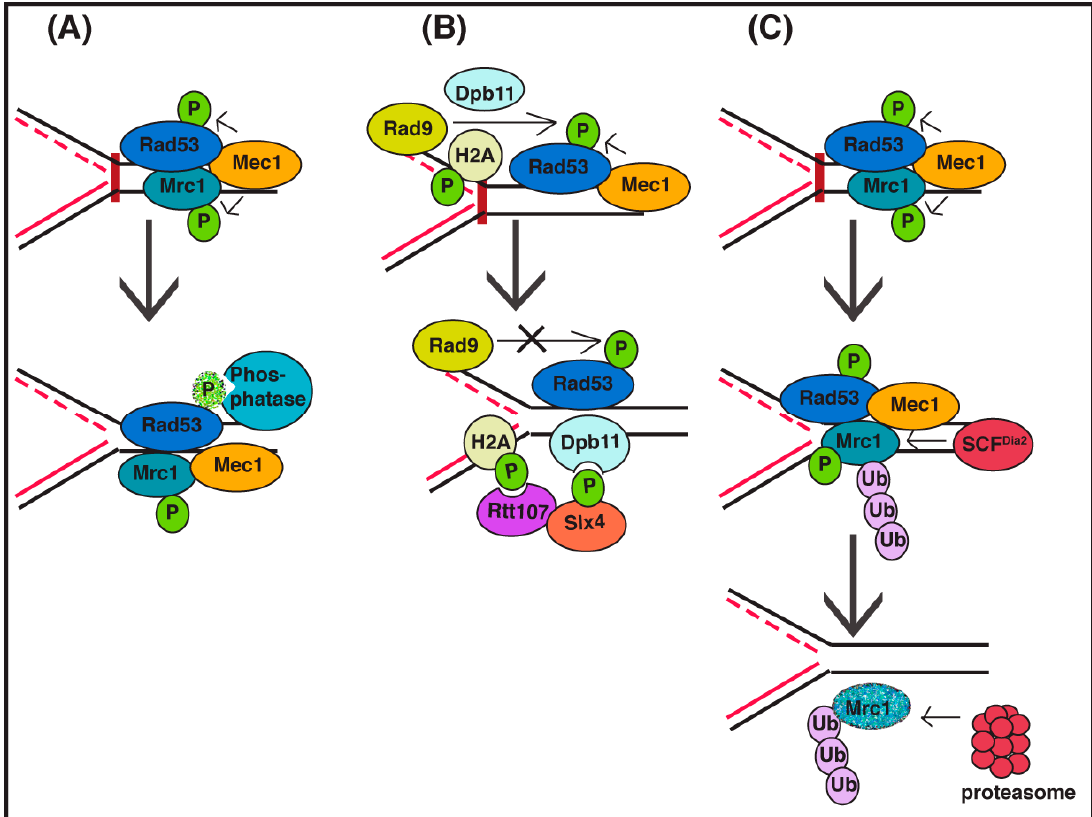
Figure 1. Diagram of DNA replication checkpoint signaling inactivation mechanisms. ( A ) During recovery, phosphatases from the PP2A and PP2C families de-phosphorylate Rad53, thus abrogating checkpoint signaling; ( B ) Competition for binding Rad9 (a Rad53 adaptor) by the Rtt107/Slx4 complex can dampen checkpoint signaling; ( C ) Ubiquitin-mediated degradation of the Rad53 kinase adaptor Mrc1, facilitated by the SCF Dia2 ubiquitin ligase, promotes checkpoint recovery.